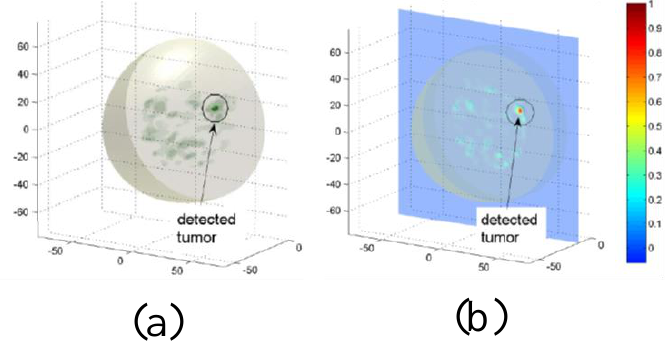
Figure 17. Clinical imaging results using a radar-based UWB microwave system developed by Klemm et al. [76]. ( a ) A 3D image. ( b ) A 2D image showing the presence of a tumour. Reprinted with permission from